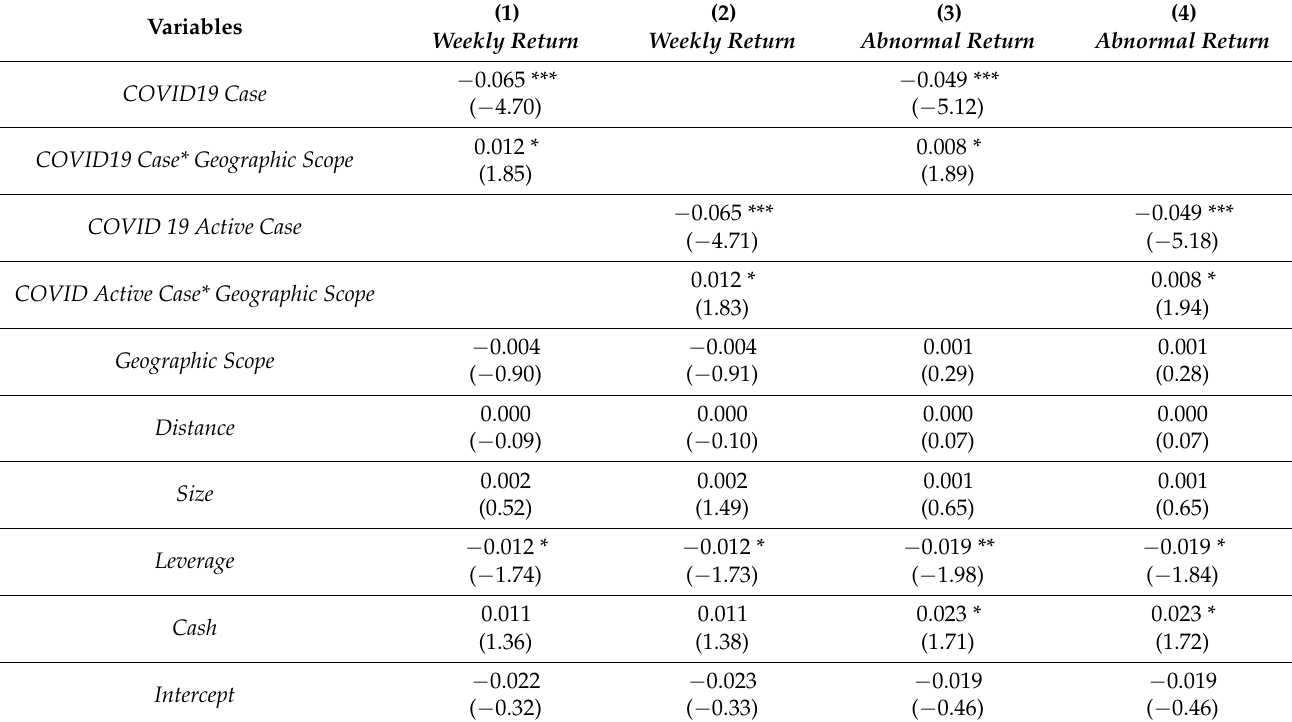
Table 5. Robustness analysis of geographic scope and stock market returns during the COVID-19 pandemic.